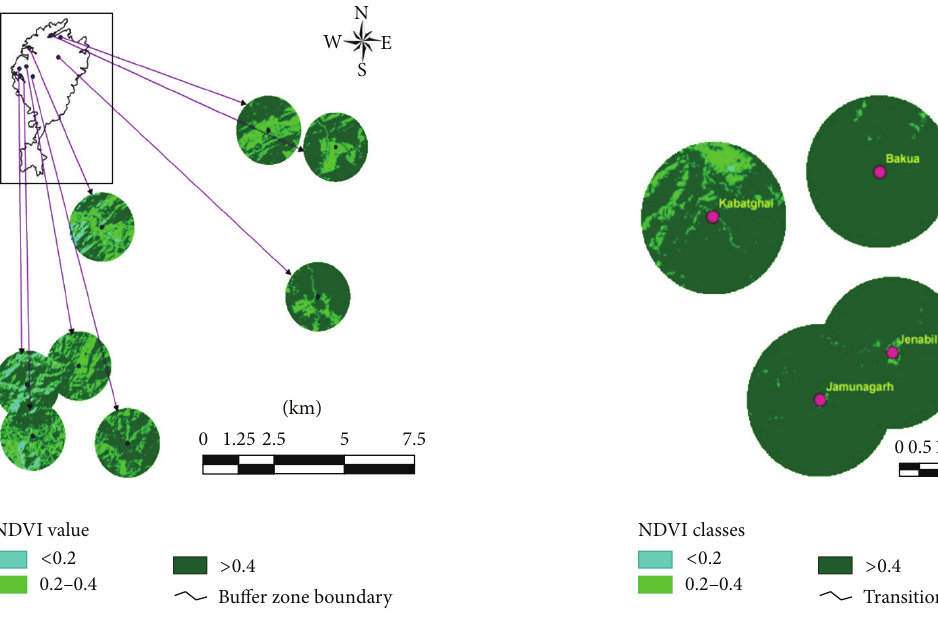
Figure 5: Vegetation density map in terms of NDVI classes in 3 km buffer area surrounding dense road points for 2005.